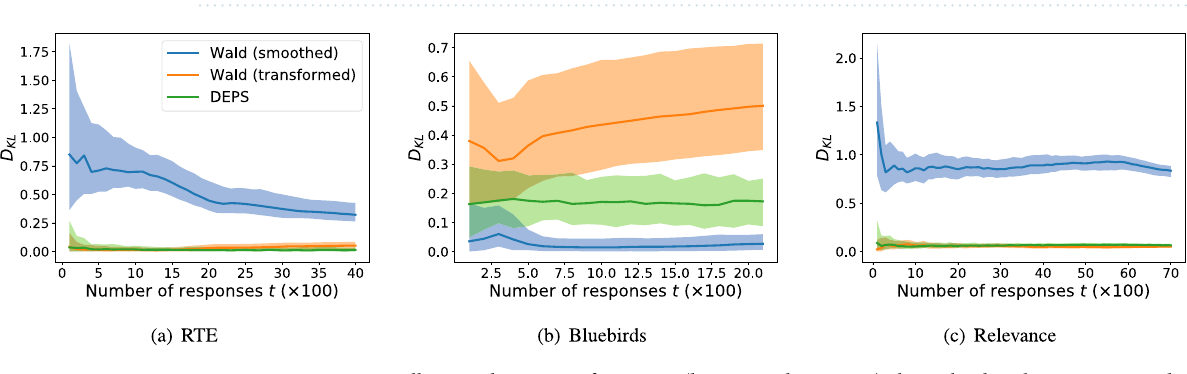
Figure 5. DEPS generally provides more information (lower KL-divergence) about the distribution estimated using the full, unbiased dataset than Wald, whose performance degrades as more (biased) data are received, with the exception of Bluebirds. Shaded areas denote 95% CI computed over Requallo